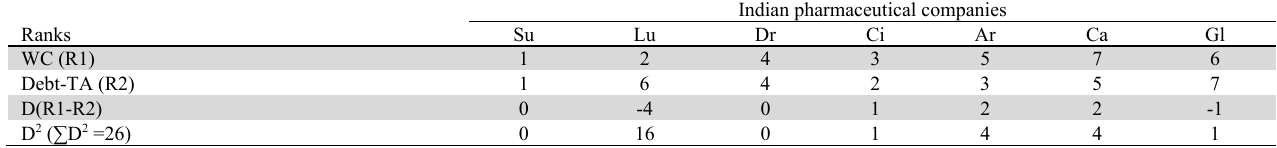
Originating Source: R1 and R2 from Table 1 and Table